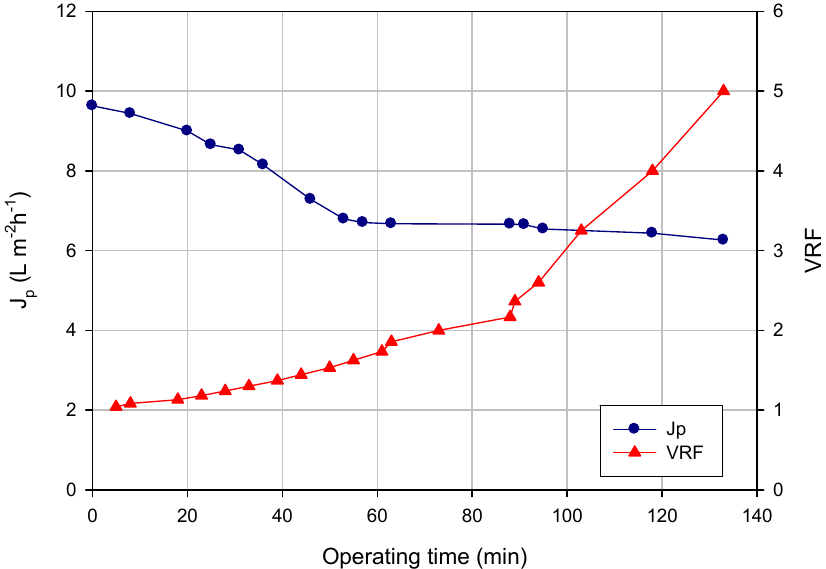
Figure 2. The NF of orange press liquor. The time course of permeate flux and VRF (operating conditions: TMP, 8 bar; Q , 400 L·h − 1 ; temperature, 20 f